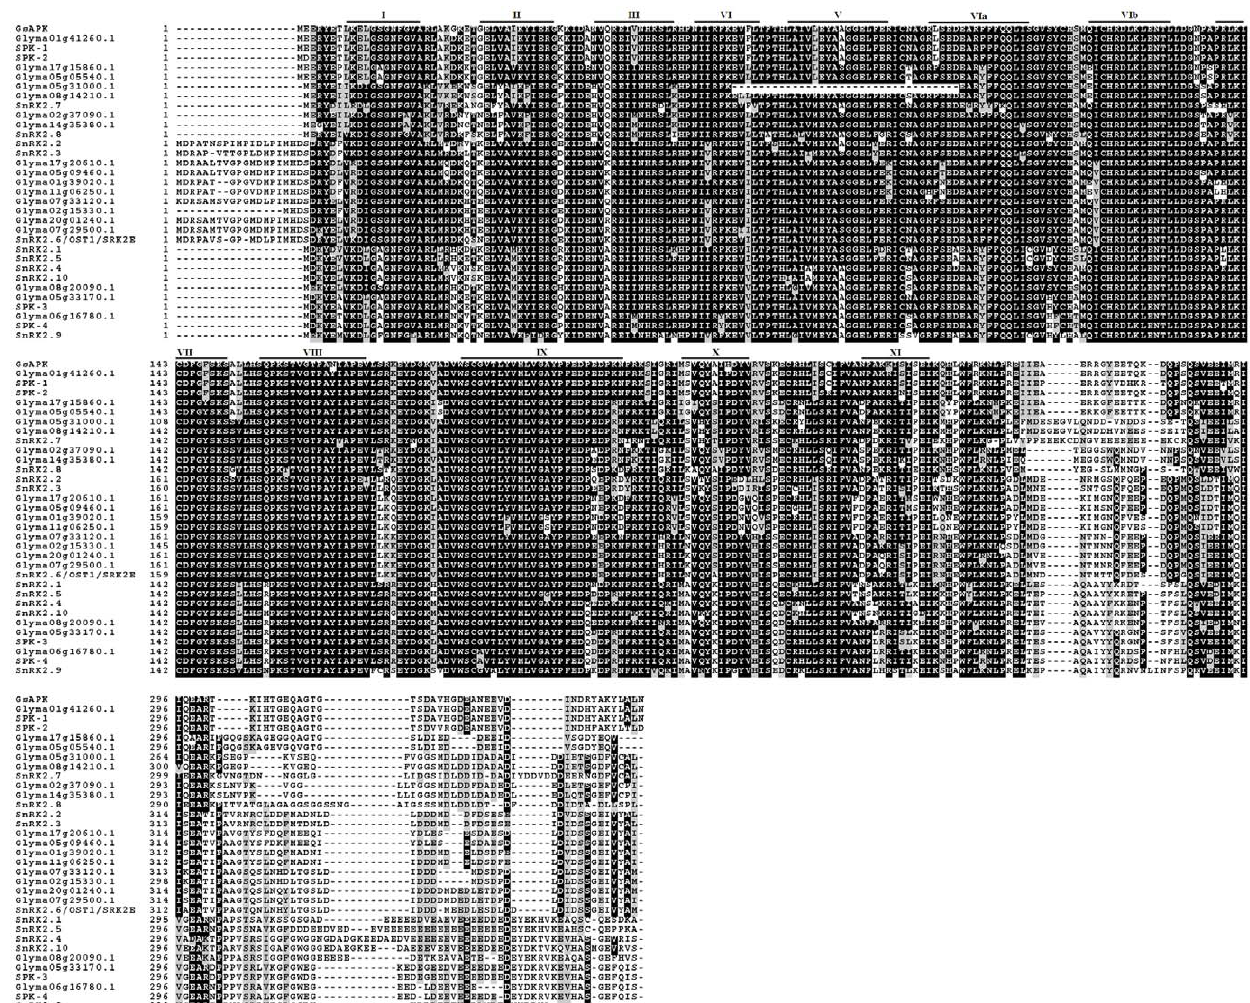
Figure 1. Amino acid sequence alignment of GsAPK and all SnRK2 family members of soybean and Arabidopsis . Multiple sequence alignments were conducted using ClustalW (version 1.8.1) and presented using BOXSHADE (version 3.21; http://www.ch.embnet.org/software/BOX_ form.html). Identical amino acid residues are boxed, and similar residues are shaded in gray. Dashes indicate gaps in the sequences to allow maximum alignment. The subdomains of catalytic domain are marked by a solid line. Arabidopsis Genome Initiative identification numbers of the Arabidopsis SnRK2 members are as follows: SnRK2.1 (At5g08590), SnRK2.2 (At3g50500), SnRK2.3 (At5g66880), SnRK2.4 (At1g10940), SnRK2.5 (At5g63650), SnRK2.6/OST1/SRK2E (At4g33950), SnRK2.7 (At4g40010), SnRK2.8 (At1g78290), SnRK2.9 (At2g23030), and SnRK2.10 (At1g60940). OST1/ SRK2E is synonymous to SnRK2.6. Nomenclature of the soybean SnRK2 members followed that of the Phytozome v5.0: Glycine max database (http:// www.phytozome.net/soybean) and the GenBank accession numbers of the sequences from soybean are as follows: SPK-1(AAA33979), SPK- 2(AAA34017), SPK-3(AAB68961) and SPK-4(AAB68962).